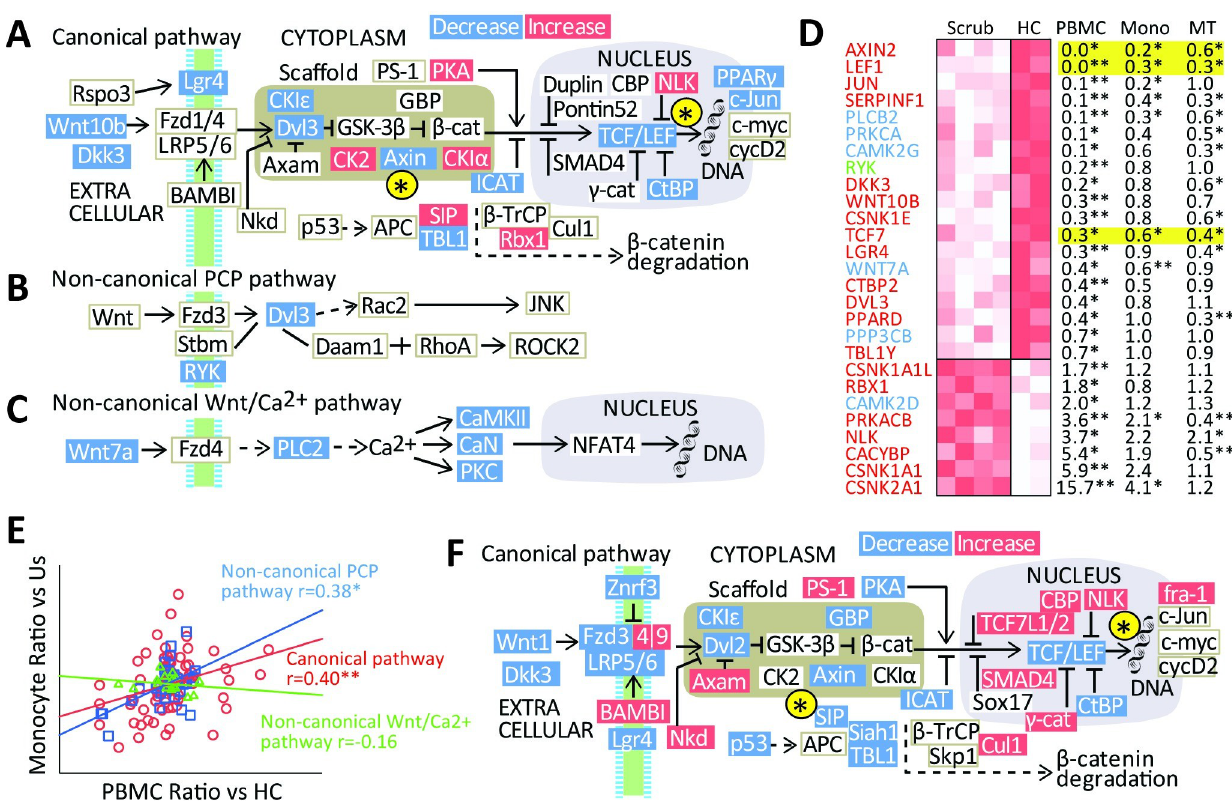
Fig 3. Regulation of Wnt pathways by O . tsutsugamushi in mononuclear cells and PBMC, data from public repositories. Differences in Wnt pathway gene expression in PBMC between patients with scrub typhus and healthy controls (HC). Significant results (FDR adjusted p-values) are indicated in red/ blue (for increased/decreased mRNA expression). The figure summarizes relevant genes for the (A) canonical,(B) non-canonical PCP pathway and (C) non-canonical Wnt/Ca2+ pathway. The figure is based on the Wnt signaling pathway in the KEGG database. (D) Heatmap over the regulated mRNA in the canonical pathway (red text), non-canonical PCP pathway (green) and non-canonical Wnt/Ca 2+ pathway (blue) in PBMC between patients with scrub typhus (n = 4) and healthy controls (n = 2). Red indicates a higher expression. To the right is a table over regulated mRNA between patients with scrub typhus and healthy controls (PBMC), in monocytes (Mono) infected with O . tsutsugamushi compared to non-infected cells (n = 4 in each group) and in patients with scrub typhus compared to murine typhus (MT, Scrub n = 4, typhoid n = 7). � p < 0.05, �� p < 0.01. (E) Correlation between fold change in PBMC (scrub patients vs. controls) and O . tsutsugamushi infected mononuclear cells. (F) Regulation of the canonical Wnt pathways by O . tsutsugamushi in mononuclear cells.